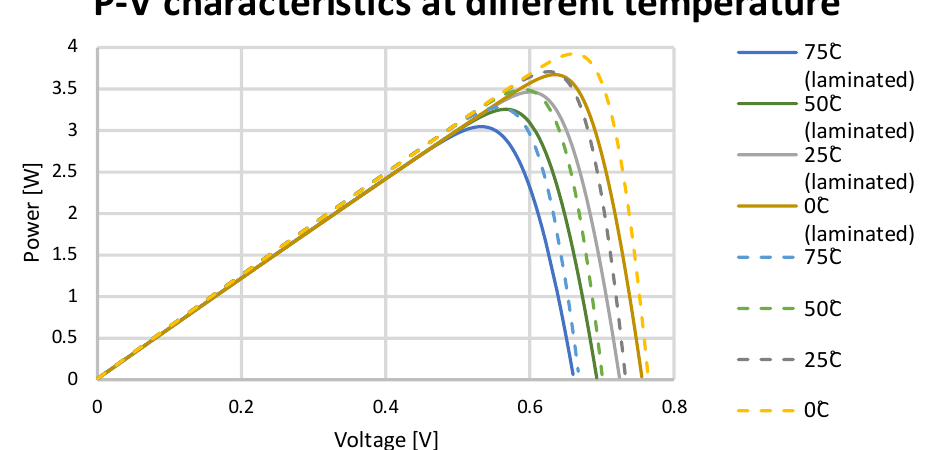
Figure 13. P–V curve at different temperatures for a SunPower Maxeon Ne3 cell. Figure 13. P – V curve at different temperatures for a SunPower Maxeon Ne3 cell. Table 6. MPPT data for tested solar cells in different temperatures. Table 6. MPPT data for tested solar cells in different temperatures.